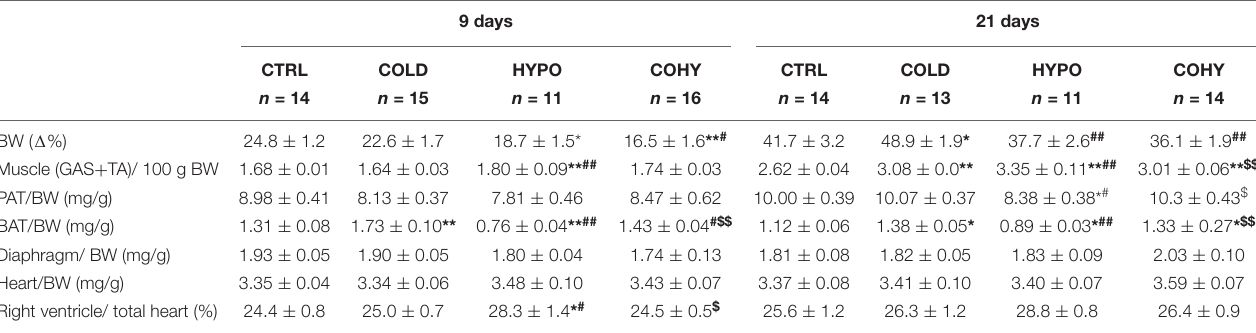
TABLE 1 | Rats’ body composition